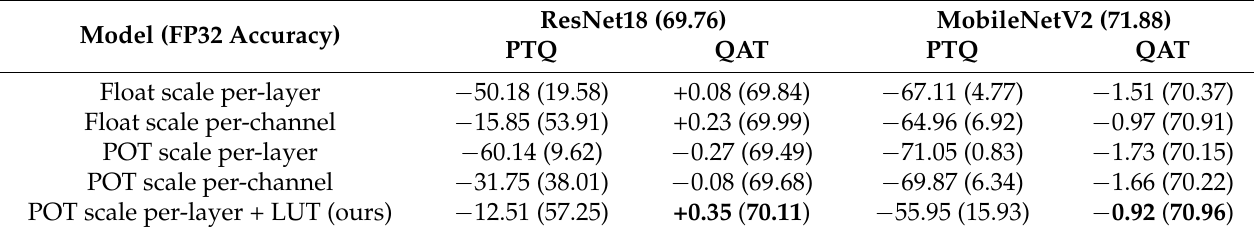
Table 1. ImageNet Top-1 results using different quantizers with 4 bit weights and 8 bit activations. The first number represents the relative accuracy or difference between the quantized model and the full-precision model, while the second number in parenthesis represents the absolute